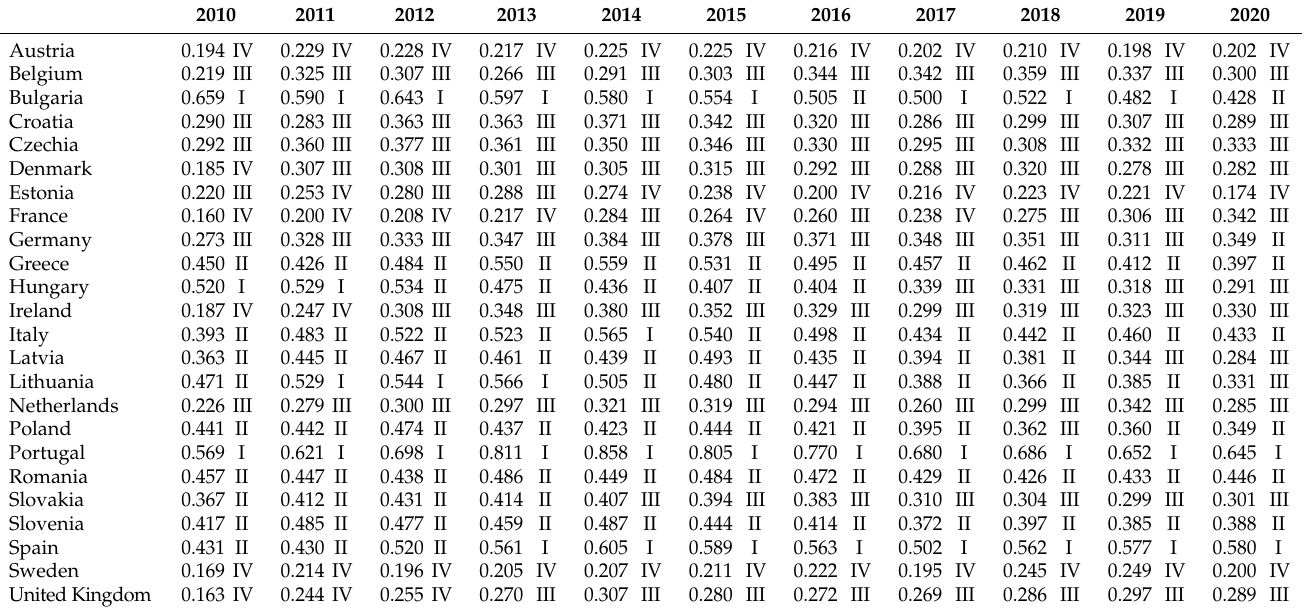
Table A3. Values of the Synthetic Multidimensional Energy Poverty Index and the rank of EU countries in terms of level of energy poverty in period